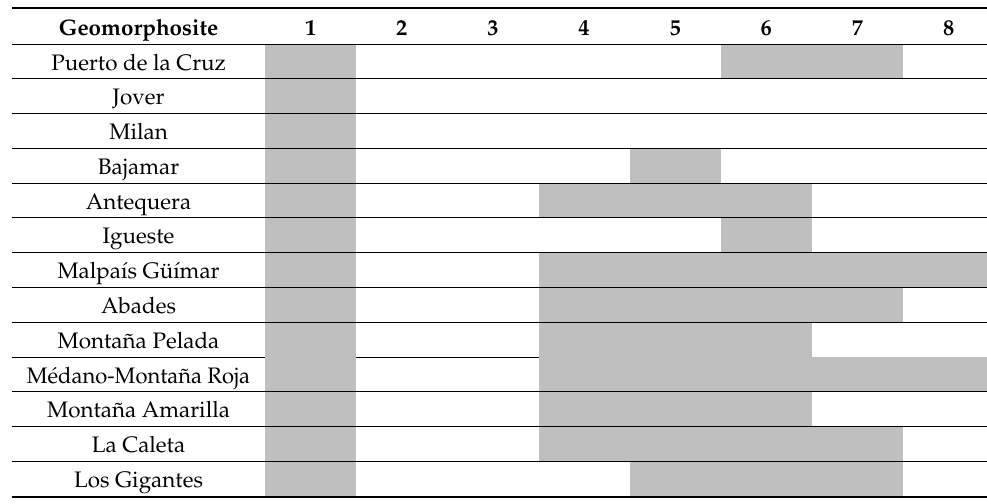
Table 4. Attractions for volcano tourism: 1. landscapes; 2. eruptions; 3. hot springs; 4. ecotourism; 5. sports; 6. beaches; 7. archaeology–cultural heritage; 8. religion. Self-elaboration based on Sigurdsson and Lopes [82] and D ó niz-P á ez